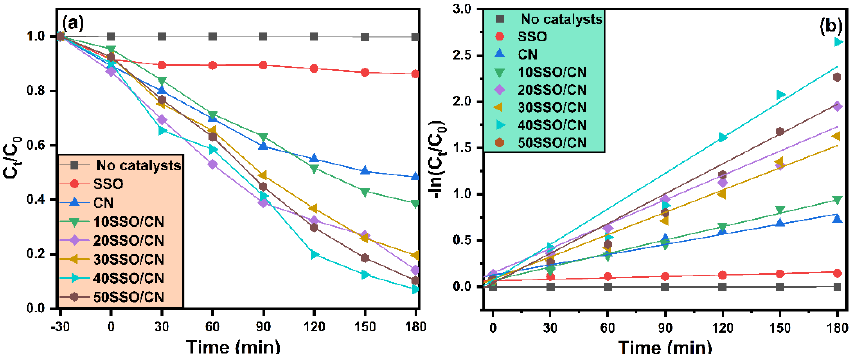
Figure 8. Photocatalytic degradation performance of as-prepared samples ( a ); kinetic curves of CIP degradation ( b ). Table 1. Photocatalytic results of all samples.